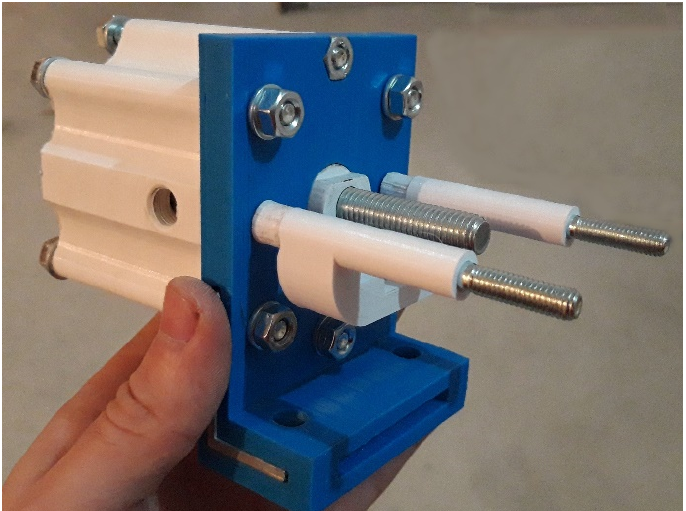
Figure 7. Preliminary design of the 3D printed actuator.